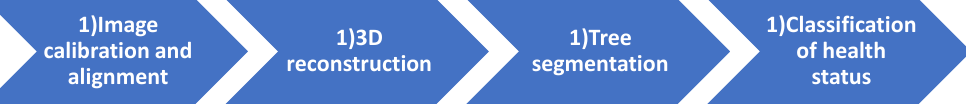
Figure 5. Main processing tasks of the proposed